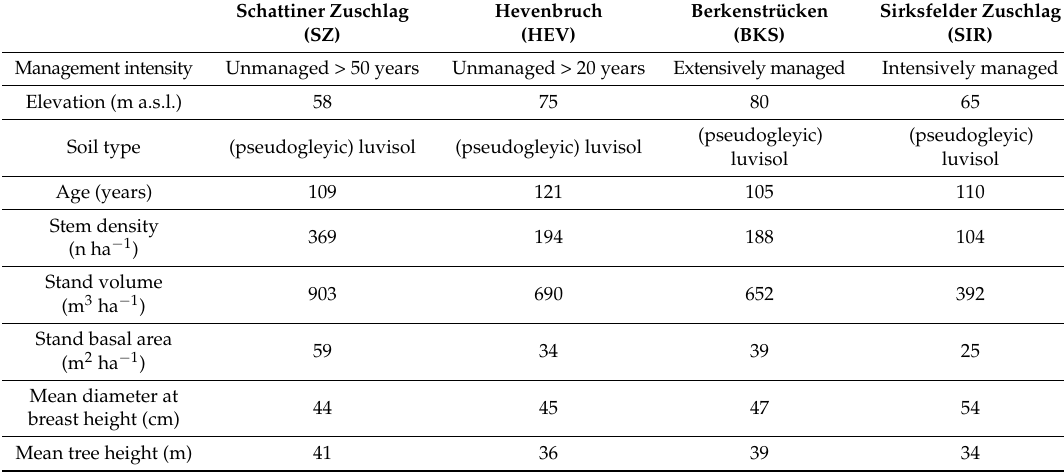
Table 1. Characteristics of the four study stands. Stand dendrological data for Schattiner Zuschlag (SZ), Hevenbruch (HEV) and Berkenstrücken (BKS) are taken from [19]. Data for Sirksfelder Zuschlag (SIR) are from G.M. Böbinger